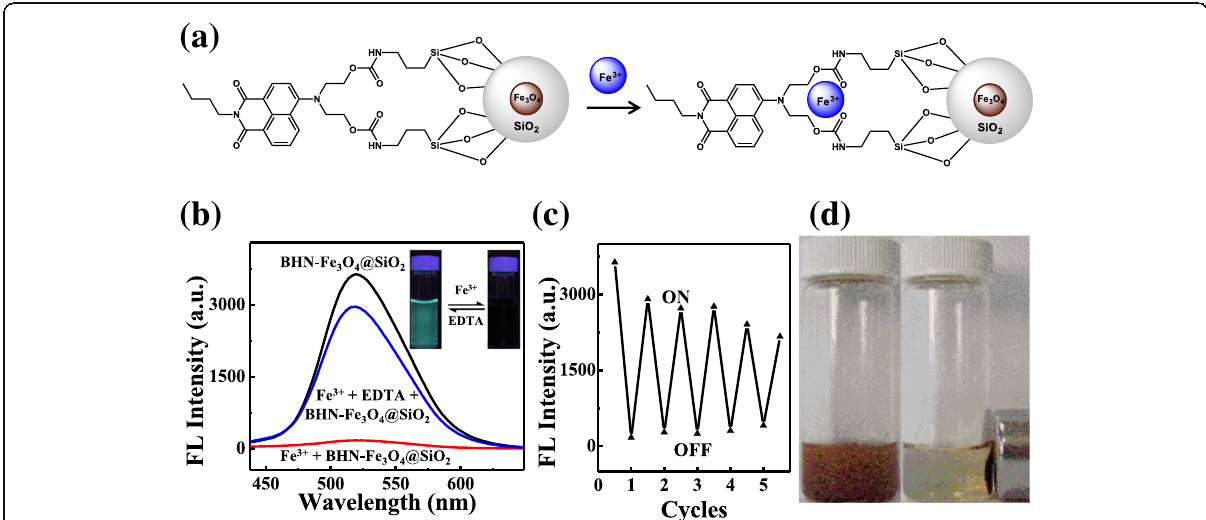
Fig. 4 a Schematic show of BHN-Fe 3 O 4 @SiO 2 with Fe 3+ . b Reversibility of BHN-Fe 3 O 4 @SiO 2 towards Fe 3+ . Inset: the photograph of BHN-Fe 3 O 4 @SiO 2 with Fe 3+ by treatment of EDTA (2.5×10 − 5 M) under 415-nm UV light. c Plot of the fluorescence of BHN-Fe 3 O 4 @SiO 2 (0.2 g/L) with alternate adding of 2.5×10 − 5 M Fe 3+ ( “ off ” ) and EDTA ( “ on ” ). d BHN-Fe 3 O 4 @SiO 2 (0.2 g/L) was dispersed to an external magnet in CH 3 CN/H 2 O 1:1 (HEPES buffer pH